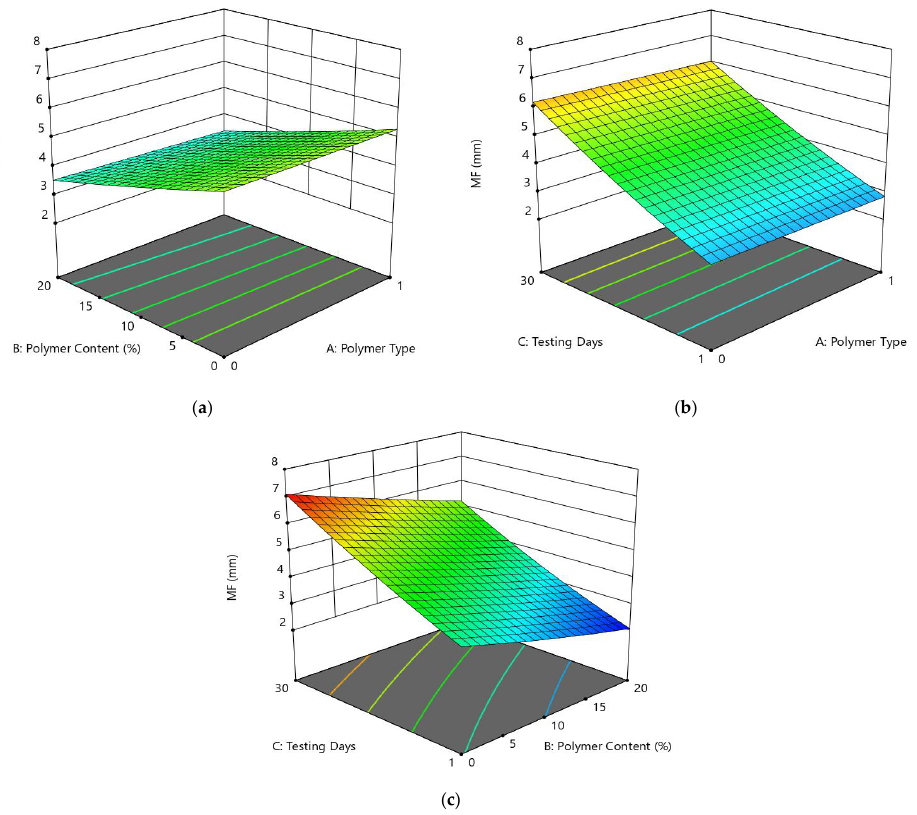
Figure 13. 3D response surface plots for the MF (mm) vs. ( a ) AB, ( b ) AC, ( c ) BC